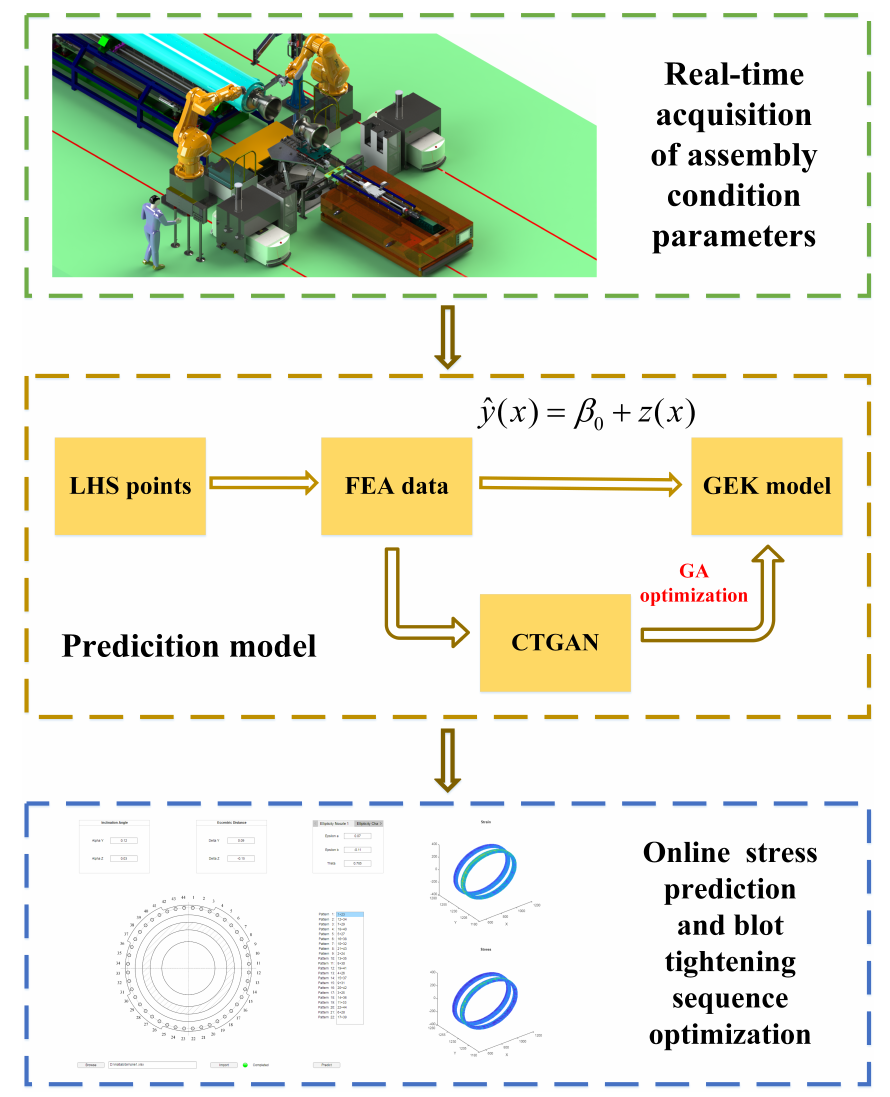
Figure 11. Workflow of the prediction